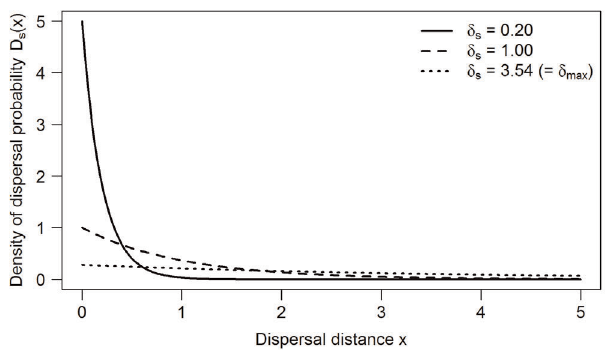
Figure 2. Dispersal kernel for three different species dispersal abilities d s . d s =0.20 (plain line), d s =1.00 (dashed line) and d s =3.54 (= d max , maximal value in this study) (dotted line).